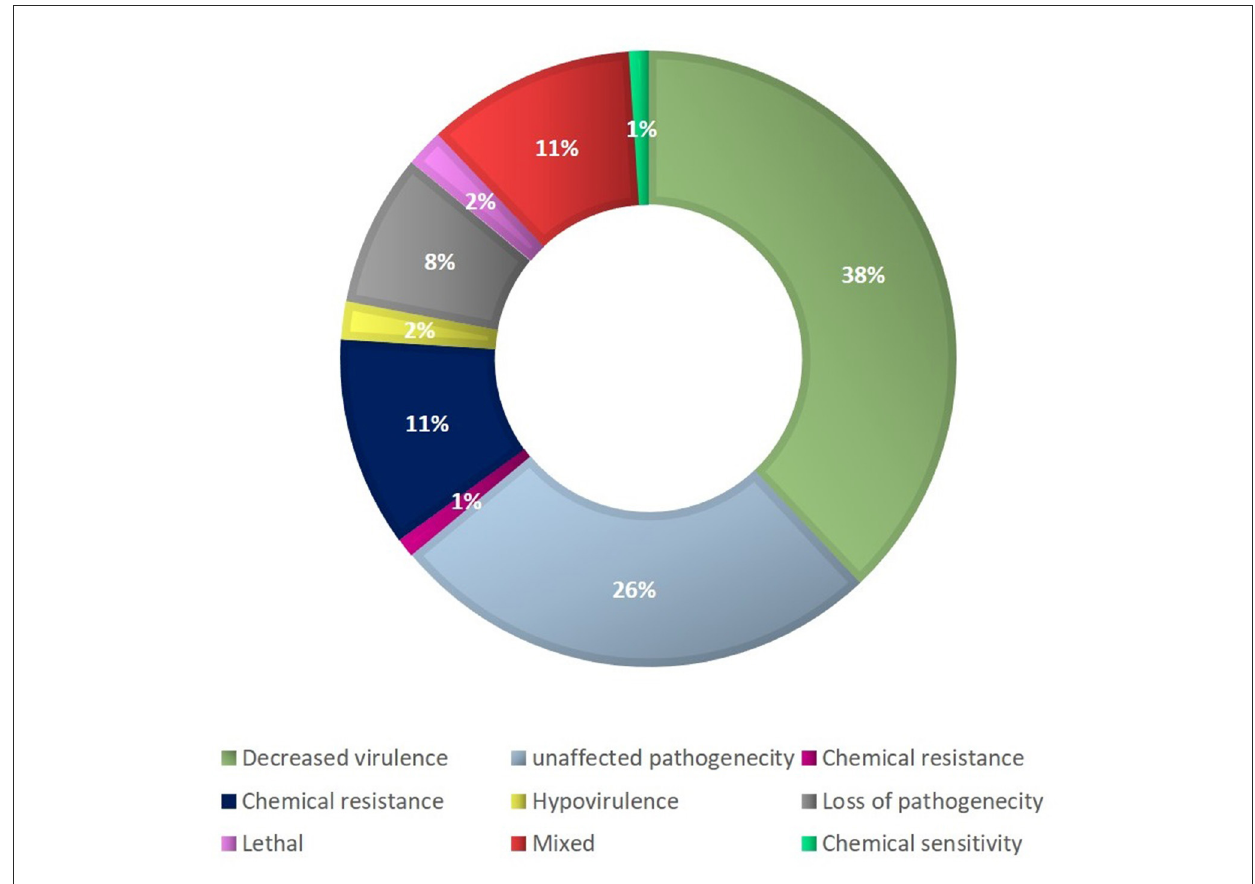
FIGURE5 Categories of secretome genes of F. fujikuroi (Bashyal et al.,